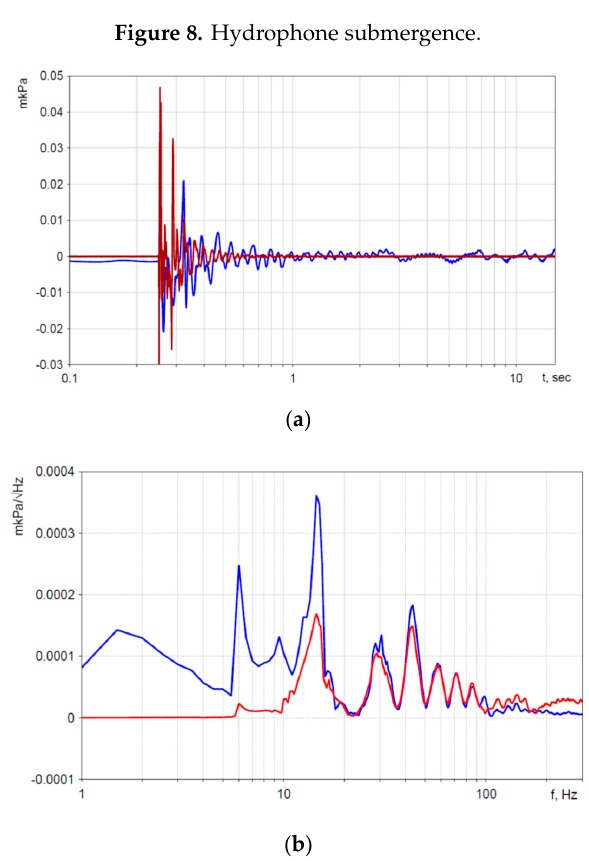
Figure 9. Signal ( a ) and spectra ( b ) of the hydrophone signals of the same shot in the marine test: blue line = MET hydrophone; red line = reference hydrophone.